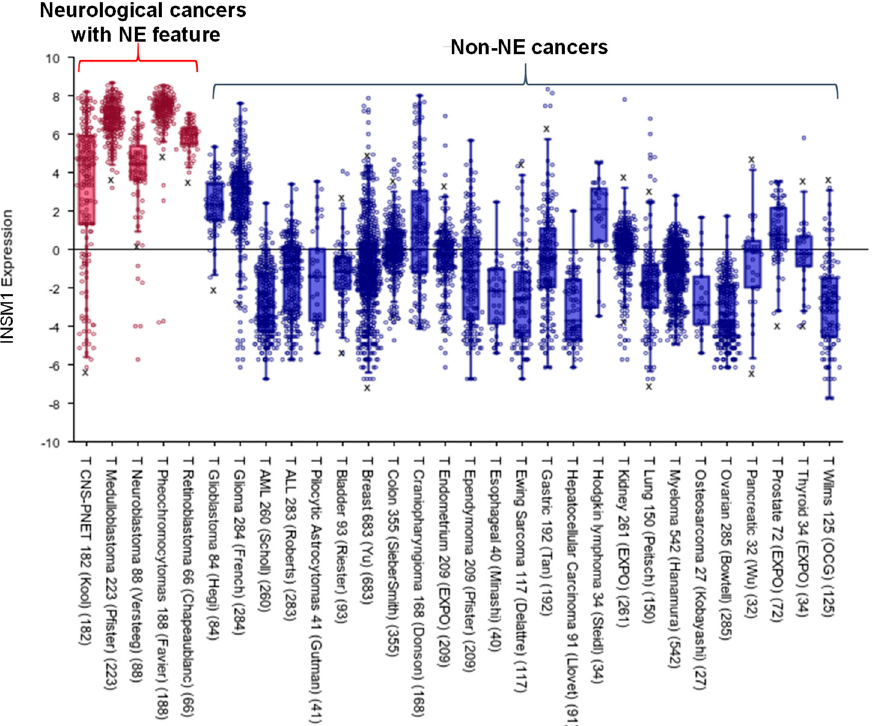
Figure 5. INSM1 expression in different tumors. INSM1 expression level in various tumors was obtained from publicly available datasets in R2: Genomics Analysis and Visualization Platform (http//r2.amc.nl, accessed on 21 February 2022). Analysis of INSM1 expression in neurological cancers with NE feature (red) and the other non-NE caners (blue) was across platforms with hs, u133p2, MAS5.0 data type for bioinformatics analyses.